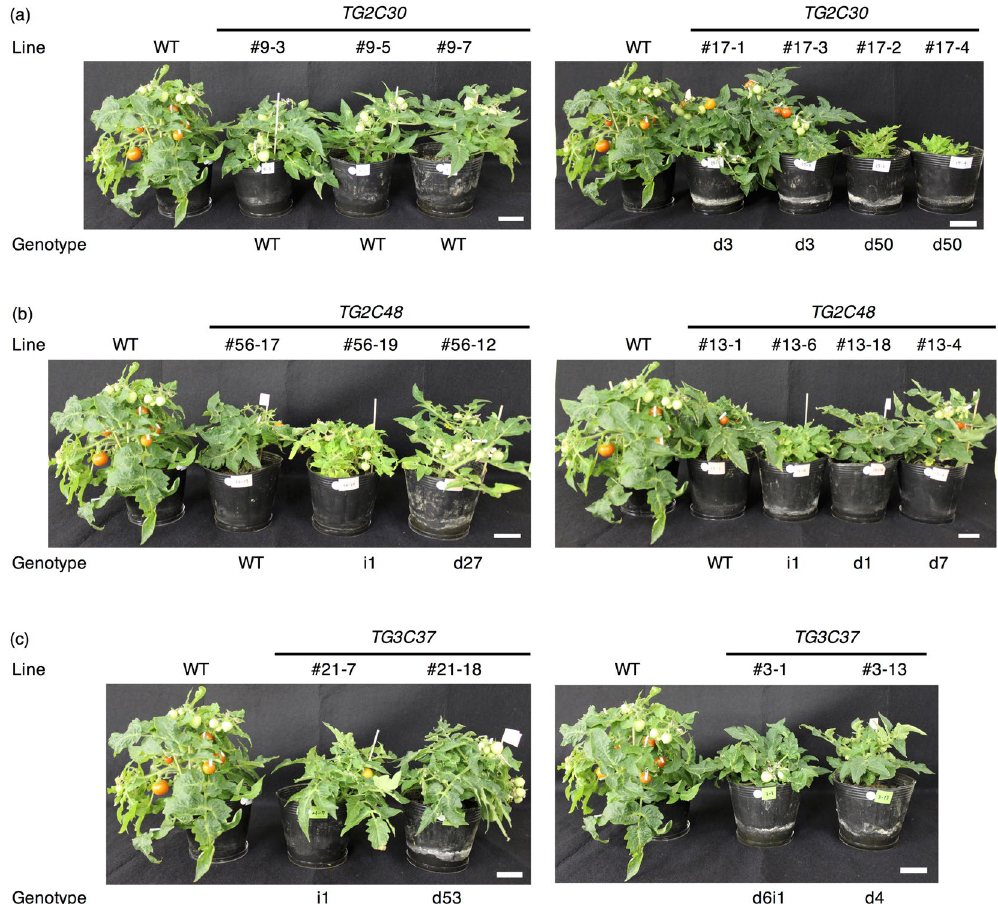
Figure 3. Plant size in 25-week-old plants in the T 1 generation. All plants were homozygous. Genotype ‘WT’ was identical to that of wild type, as no mutation was detected. ‘d’ and ‘i’ indicate deletion and insertion, respectively. Line ‘WT’ indicates a wild type plant. White bars correspond to 5